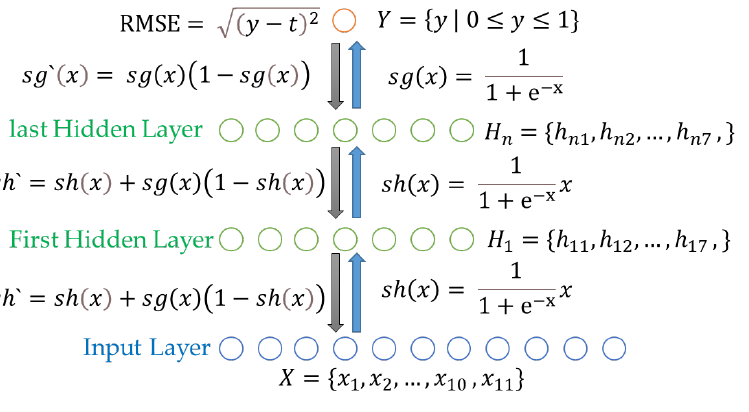
Figure 3. The structure of the BPCS.